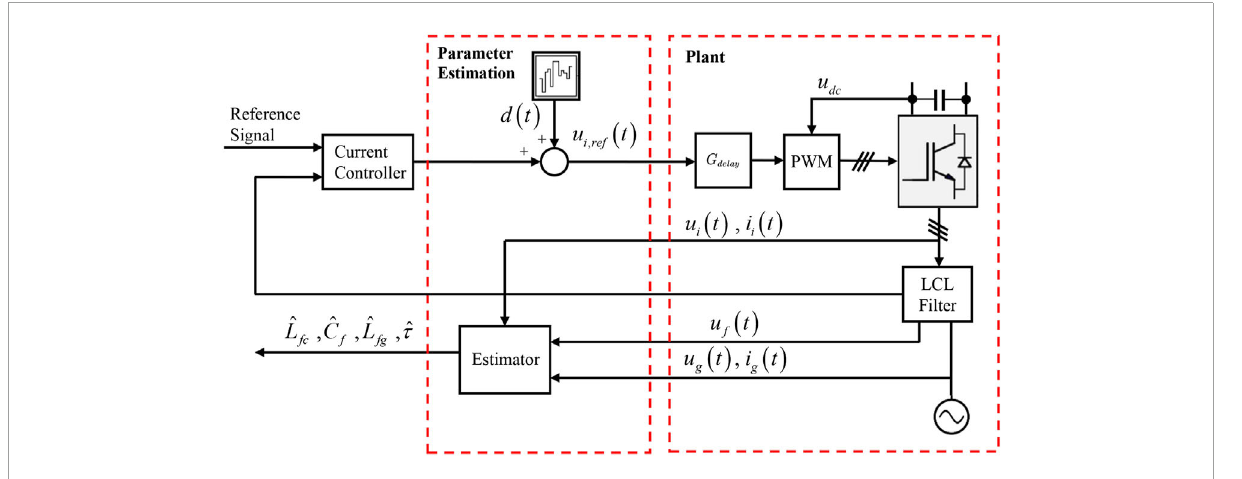
FIGURE 1 Schematic diagram of the estimation